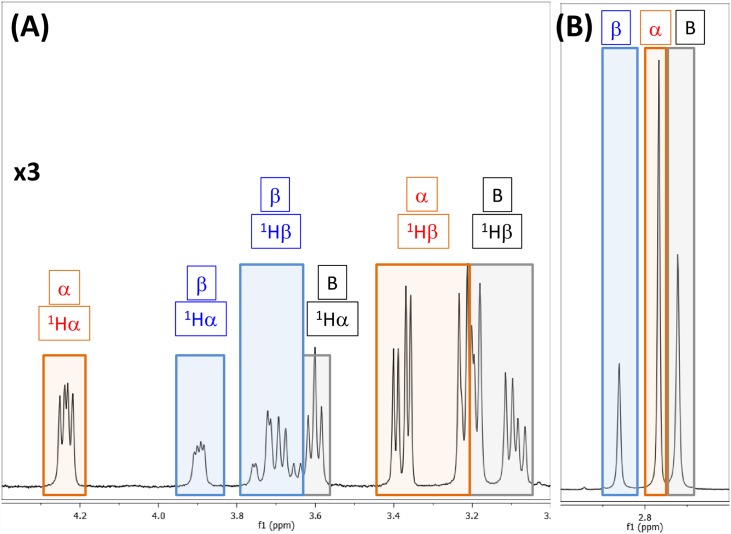
400 MHz 1H NMR spectrum of highlighting the co-existence of free BMAA (B: black boxes), α-carbamate adduct (α: red boxes) and β-carbamate adduct (β: blue boxes).The Hα and the Hβ protons are shown on the left (panel A) and the methyl protons on the right (panel B). NMR spectra were recorded with 1:20 ratio of BMAA: HCO3- (10mM: 200mM) in 100% D2O, pD of 7.6 and at 30°C.